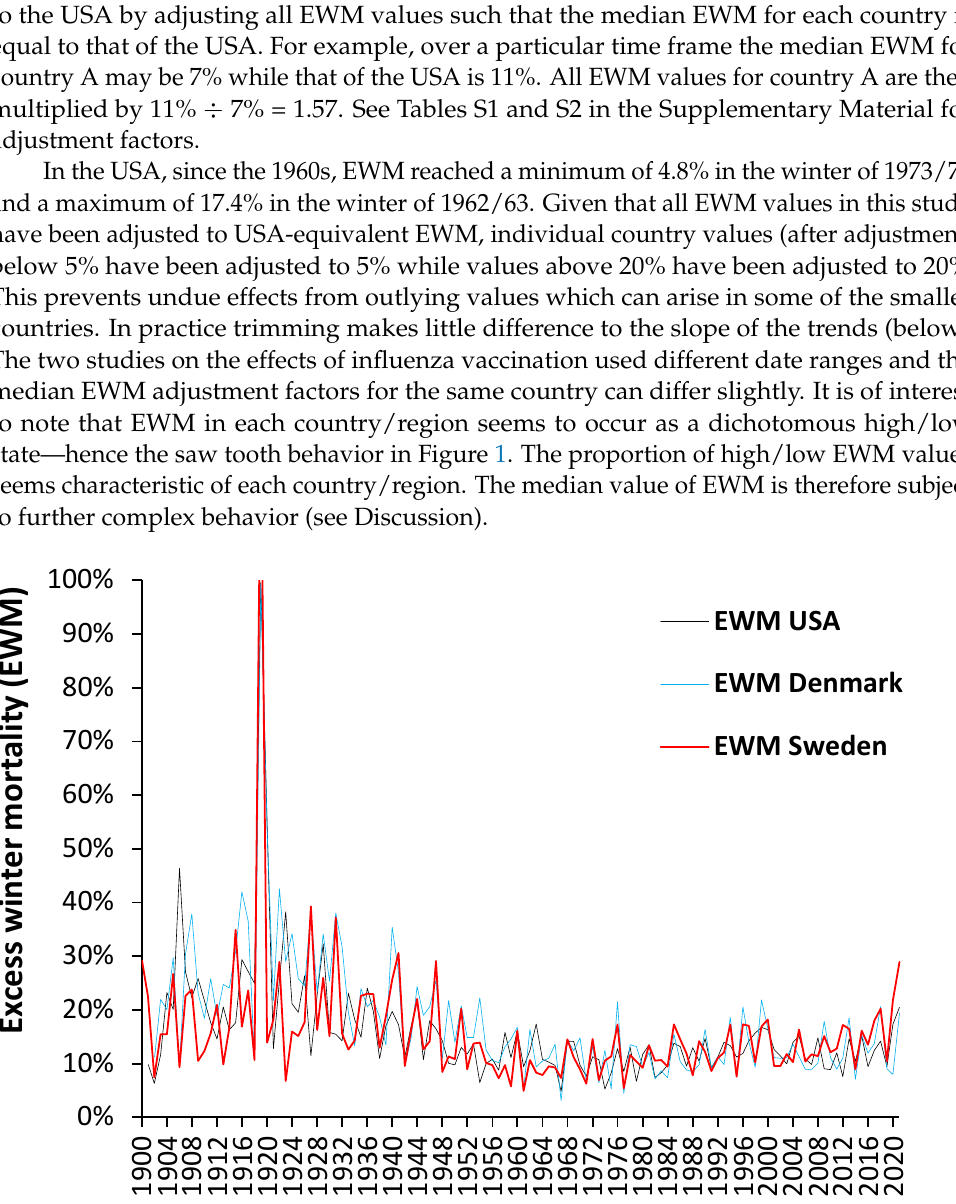
Figure 1. Excess winter mortality (EWM) over the past 120 years in Denmark, Sweden, and the USA. Note the Y -axis has been truncated at 100%.